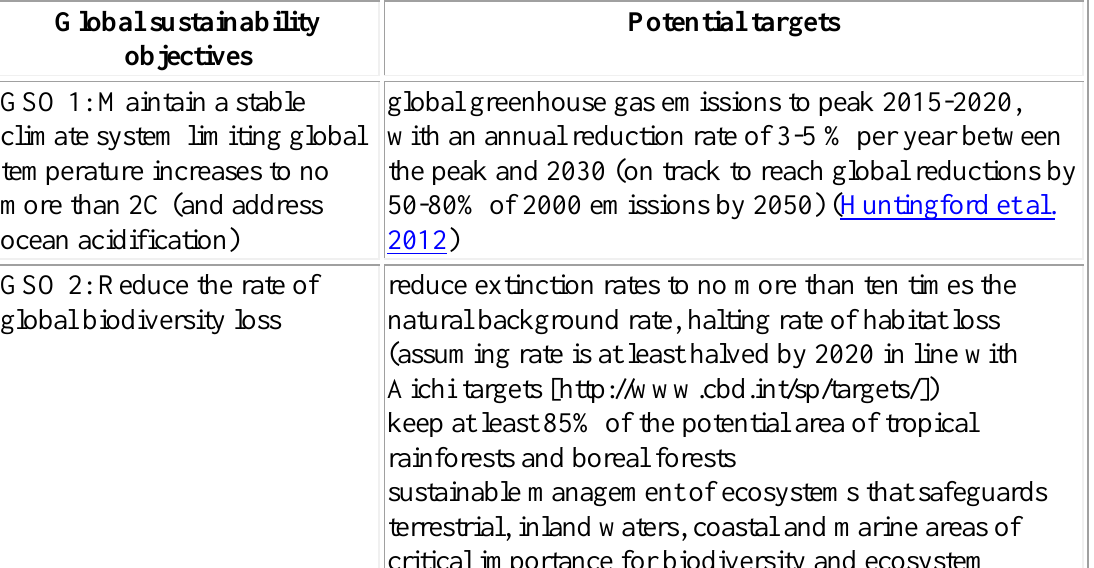
Table A2: “Planetary must-haves” or global sustainability objectives (GSOs: Griggs et al. 2013), and potential targets for these that are more or less justifiable from current literature or international